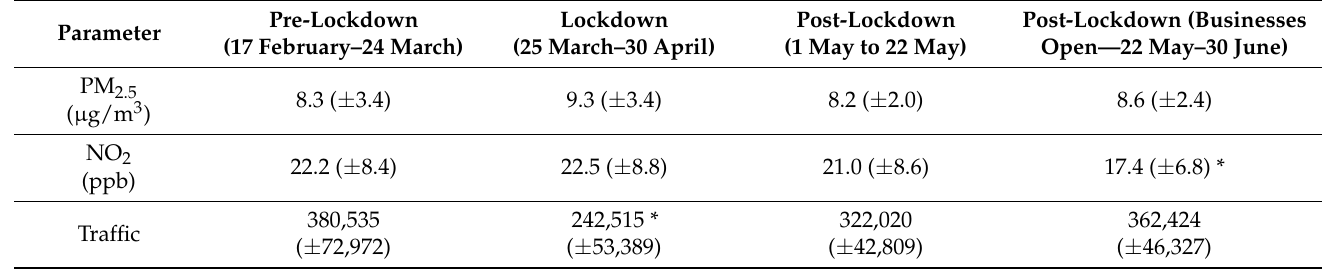
Table 3. Mean and standard deviation of PM 2.5 and NO 2 concentrations, and traffic volumes before, during and after the lockdown period in Birmingham,